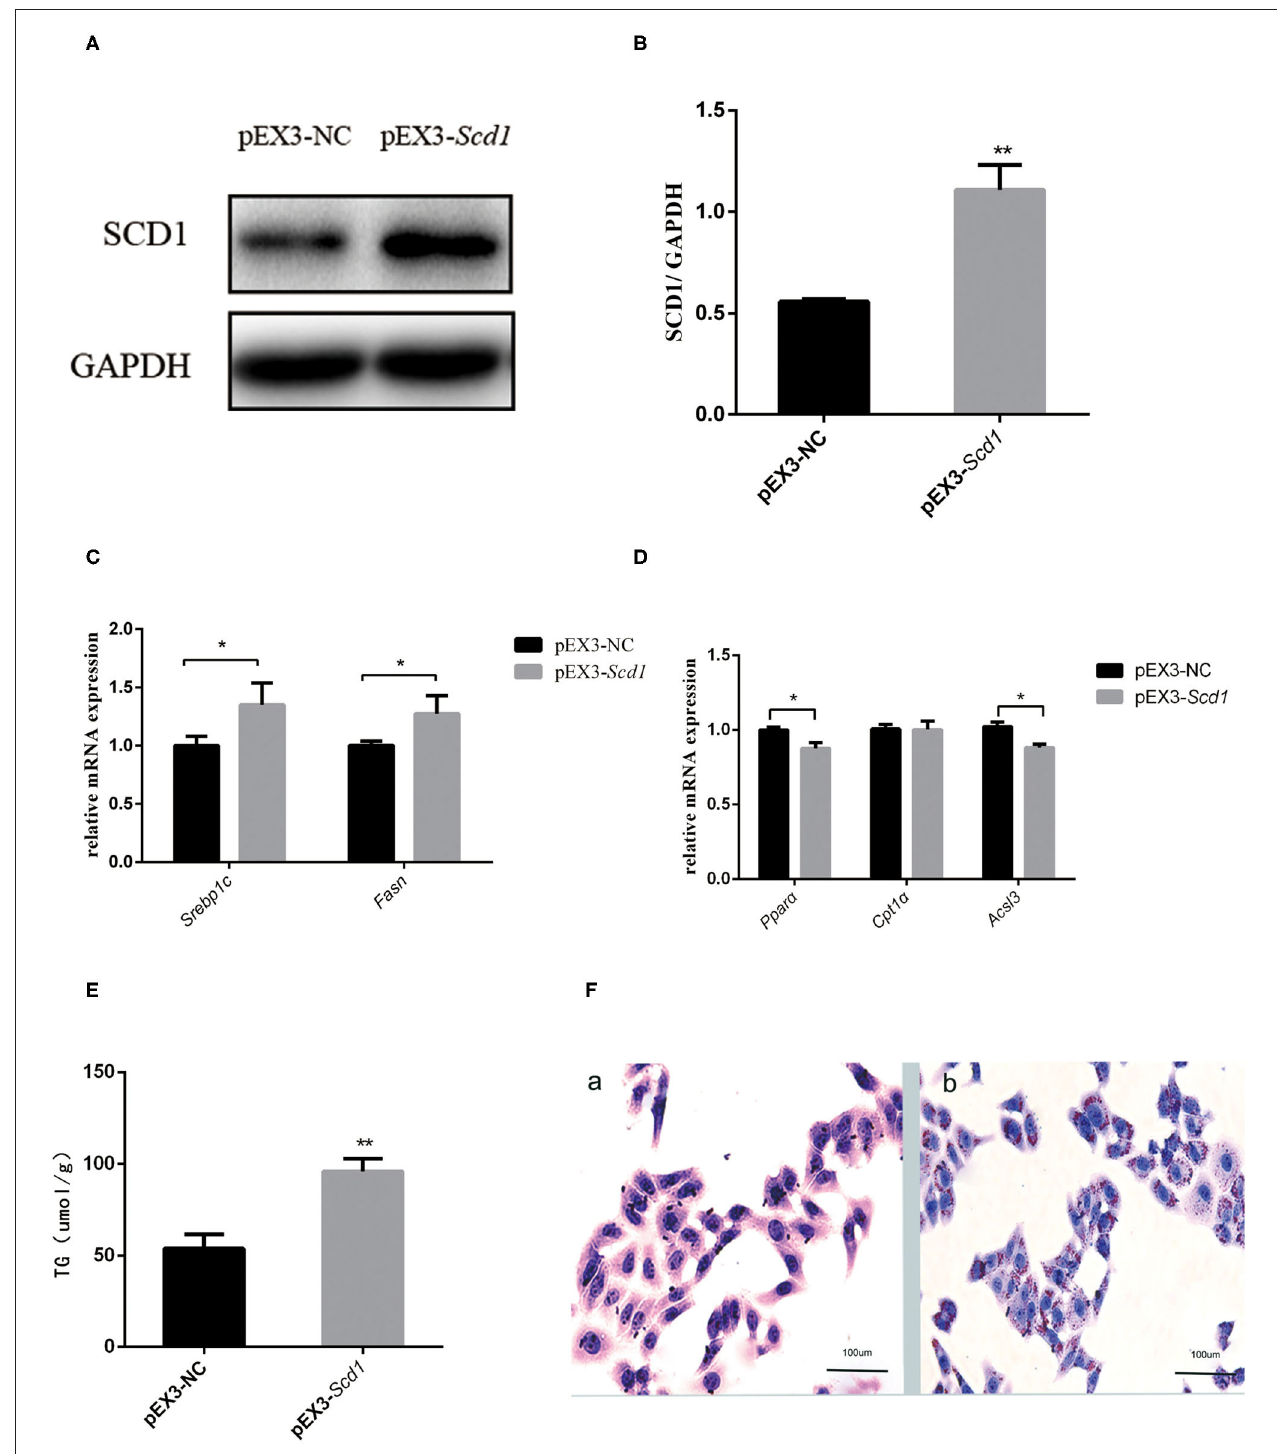
FIGURE 4 | SCD1 overexpression promotes the intracellular lipid accumulation in HepG2 cells. HepG2 cells were transfected with pEX3-NC or pEX3- Scd1 vectors. SCD1 protein levels were determined by western blot (A) and quantitatively compared (B) between two group cells. Meanwhile, mRNA levels of lipid synthesis-related genes (C) , lipid oxidation-related genes (D) , and intracellular TG levels (E) were compared as well between HepG2 cells transfected with pEX3-NC and pEX3- Scd1 vectors. Oil red O staining was performed (F) to observe the lipid droplets in HepG2 cells transfected with either pEX3-NC (a) or pEX3- Scd1 vectors (b). ** P < 0.01; * P <